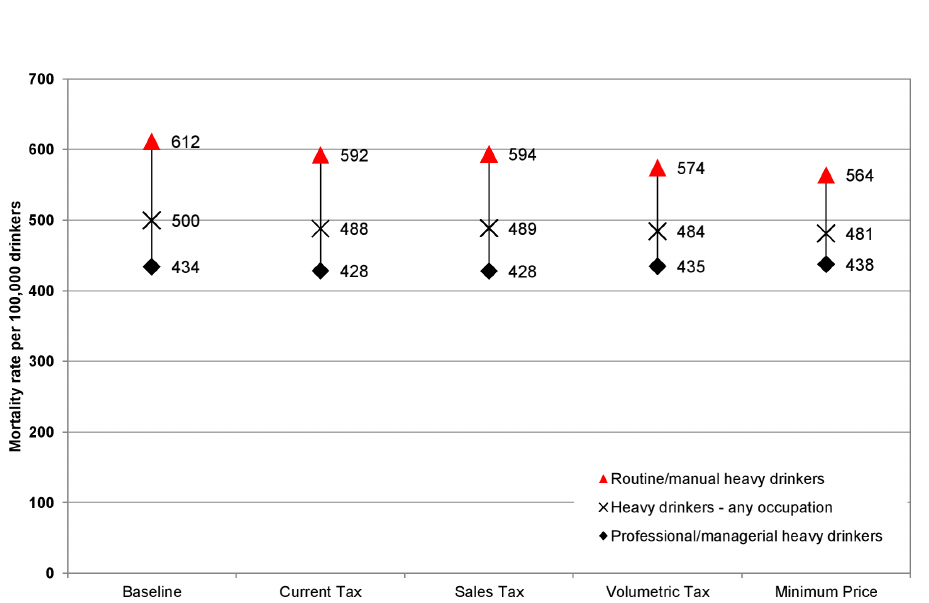
Fig 3. Equity gap in the alcohol-related death rates between those in routine/manual and professional/ managerial occupations: heavy drinkers. This figure shows the effect of alcohol pricing policies on the gap between alcohol-related death rates for heavy drinkers in the highest and lowest socioeconomic occupation groups. All policies reduce this gap, but volumetric tax and minimum unit pricing ( “ Minimum Price ” ) have larger effects on the gap than ad valorem tax ( “ Sales Tax ” ) or increasing the UK ’ s current tax ( “ Current Tax ” ).